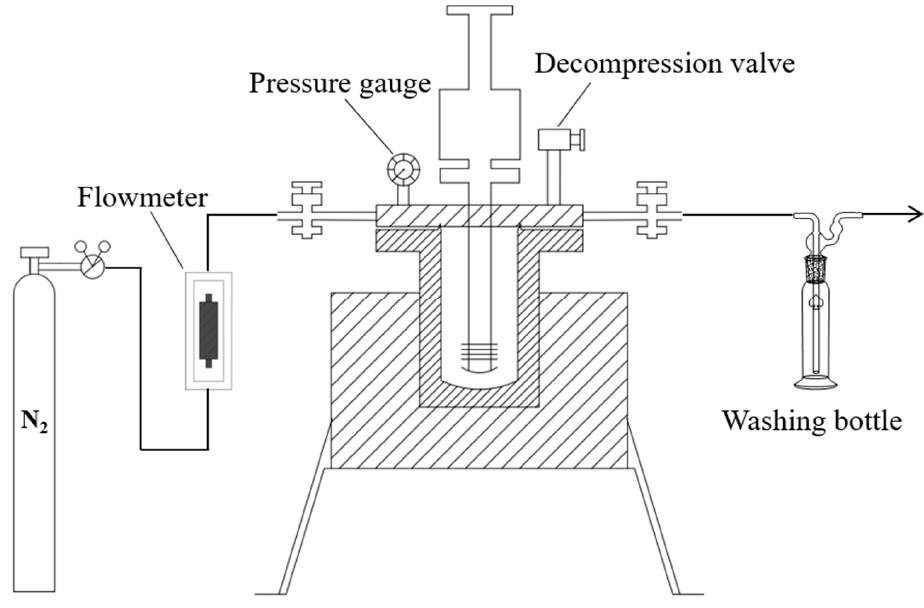
Figure 1. Schematic of pyrolysis reactor.